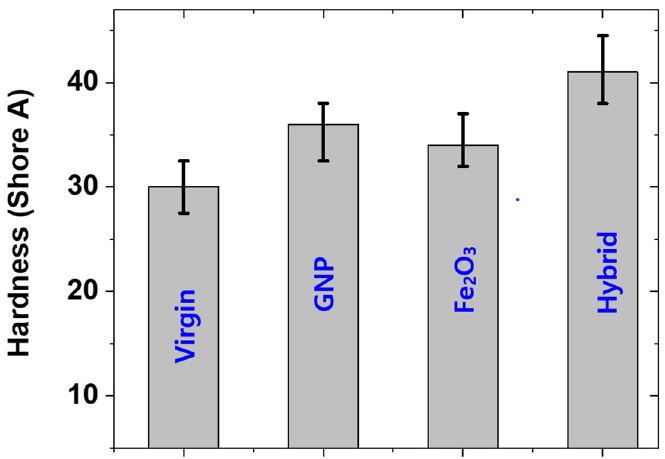
Figure 8. Hardness of different composites.